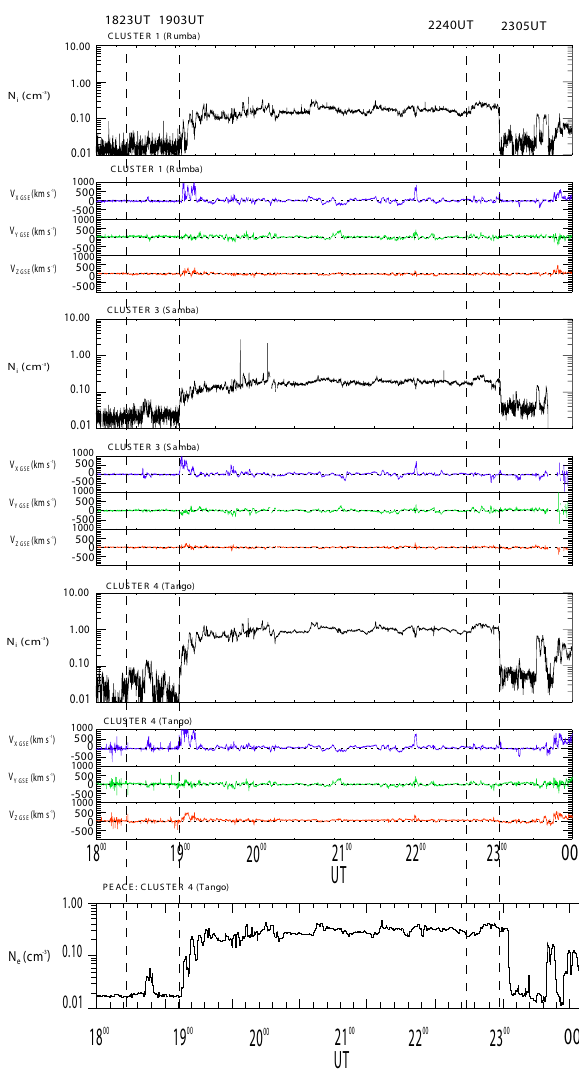
Fig. 13. Top six panels: Cluster CIS density and velocity data from the three spacecraft for 1 September 2002 (18:00 to 24:00 UT inter- val). Bottom panel: Cluster PEACE density data from Cluster 4 for the same interval.